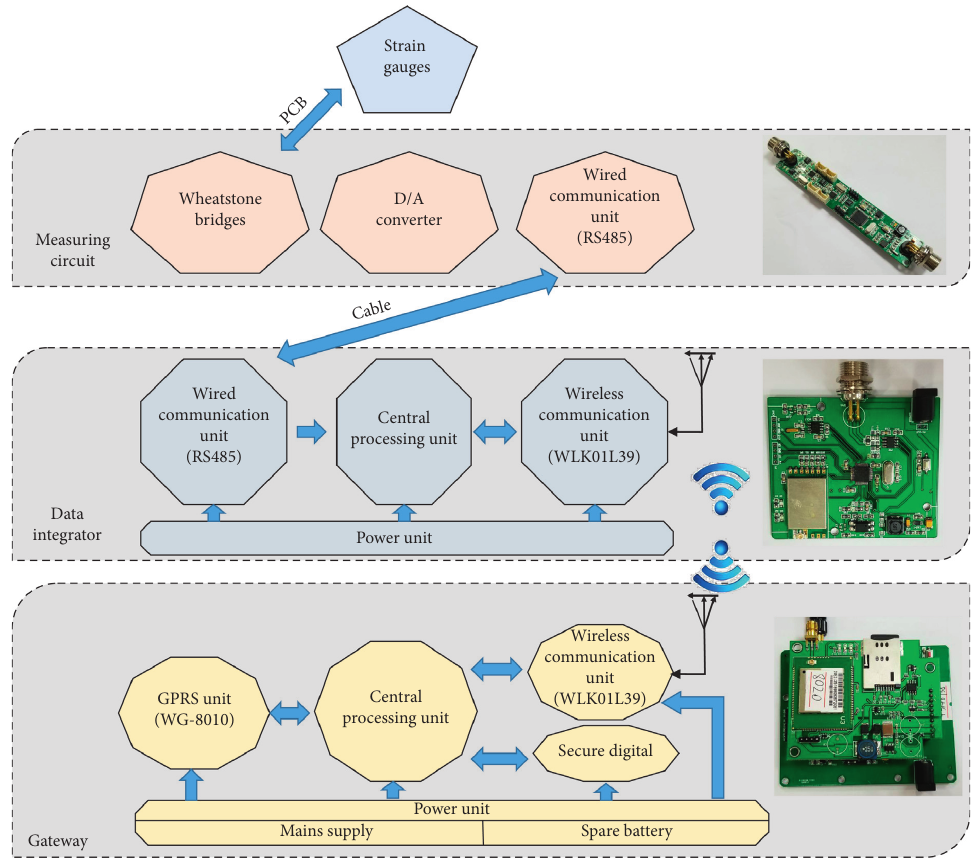
Figure 3: Structures and photographs of the electronic components of the proposed automated system.